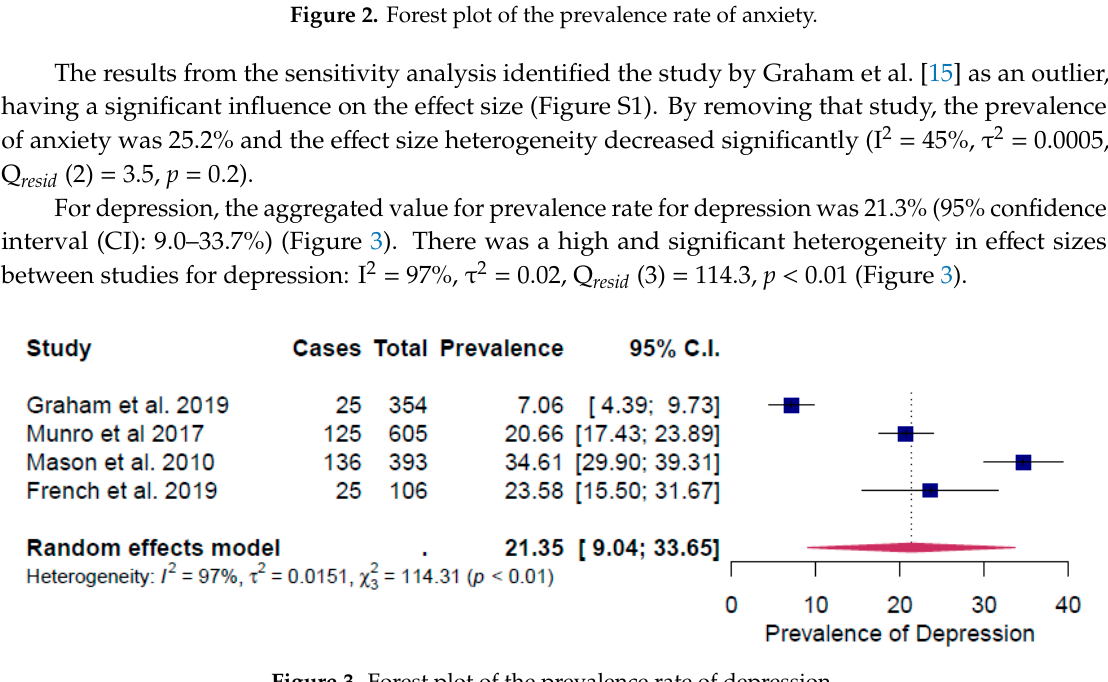
Figure 3. Forest plot of the prevalence rate of depression.